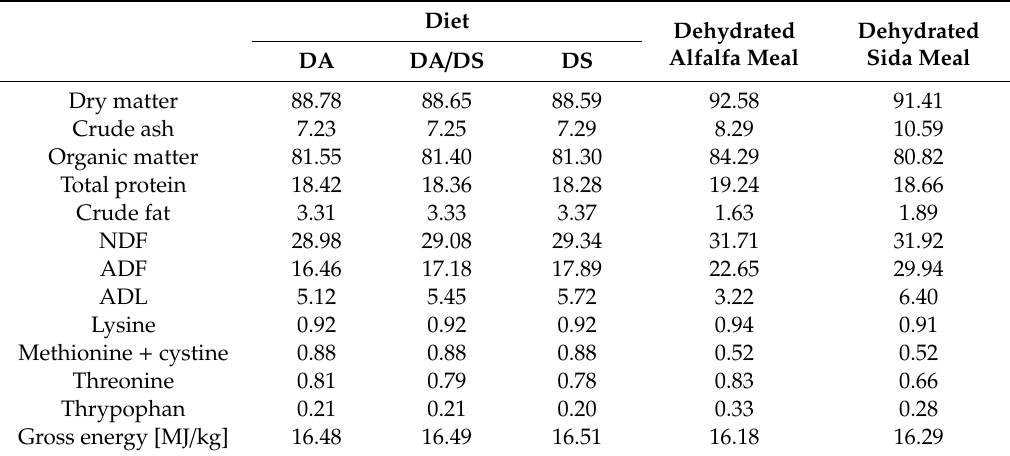
Table 2. Chemical composition of diets and experimental factors